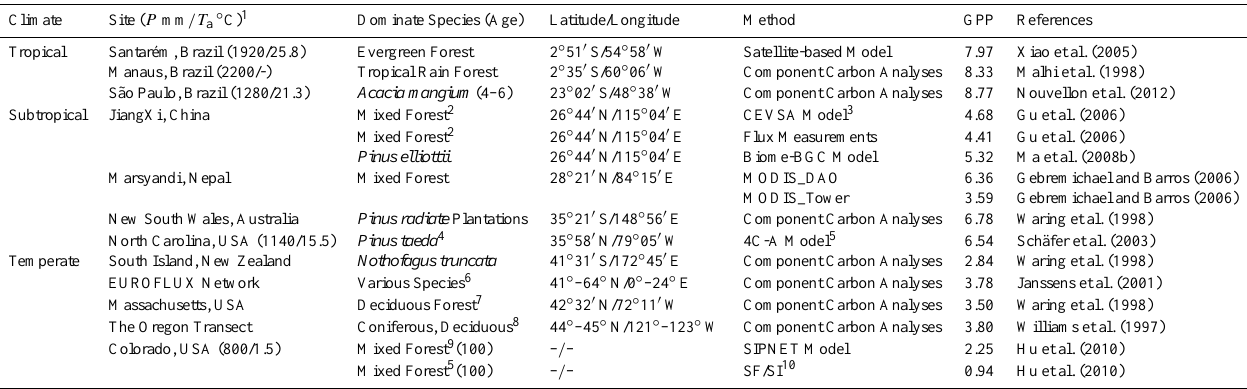
Table 5. Published estimates of gross primary production (GPP, gCm − 2 day − 1 ), species, site information and methodology, in different climate